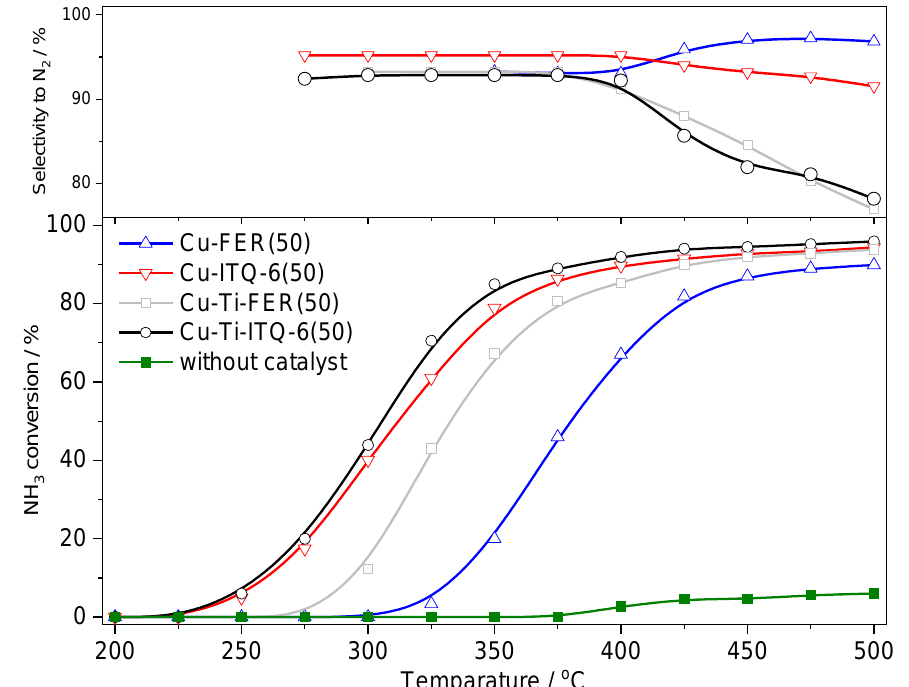
Figure 8. Results of NH 3 -SCO catalytic tests for aluminum–silicon (FER) and titanium–silicon (Ti-FER) ferrierites and their delaminated forms, ITQ-6 and Ti-ITQ-6, respectively, modified with copper by ion exchange method. Reaction conditions: 0.1 g catalyst, [NH 3 ] = 5000 ppm, [O 2 ] = 2.5%, He = balance, total flow rate = 40 mL min − 1 , and GHSV = 12,500 h − 1 . Values in brackets are intended molar Si/Al or Si/Ti ratios in the zeolite framework. Based on the results presented in [9,34] with permission from ref. [34]. Copyright 2021 The Royal Society of Chemistry.